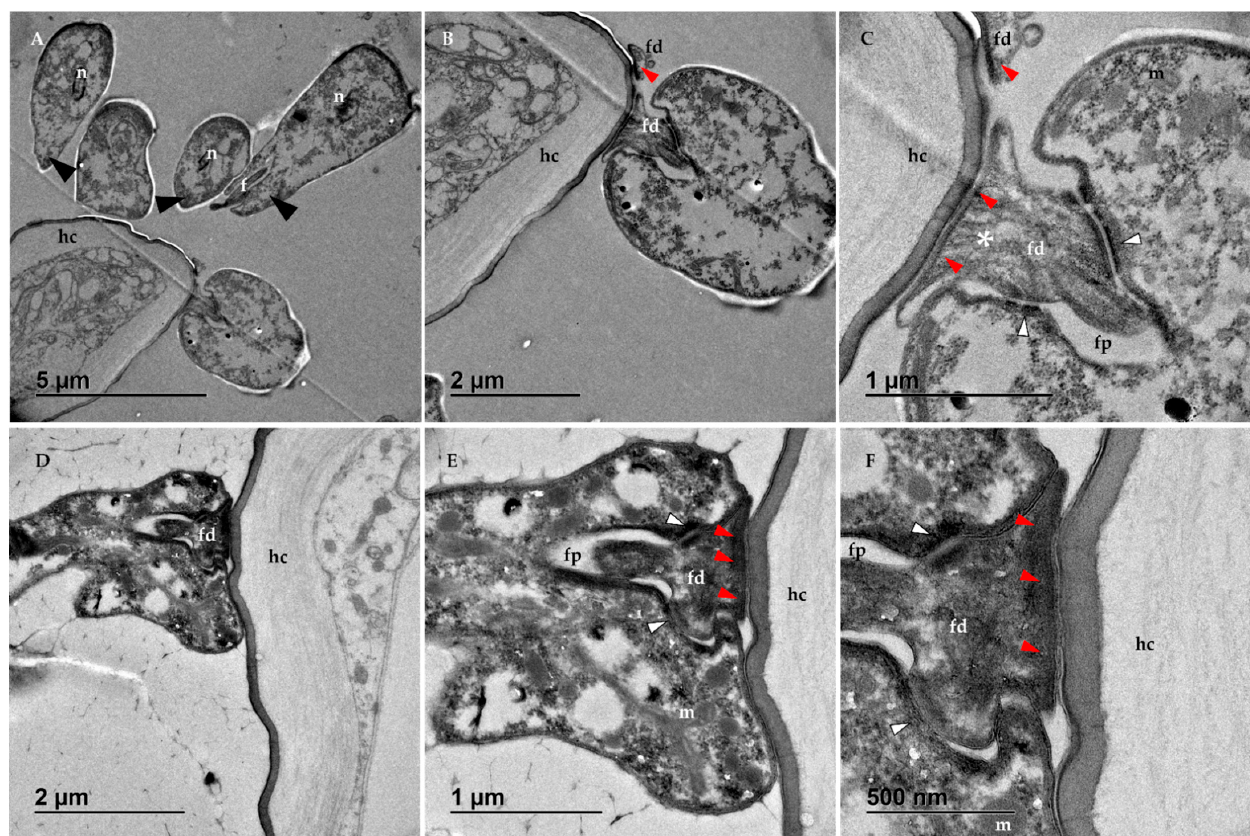
Figure 3. Transmission electron microscopy (TEM) images obtained from the rectum of C. acantho- cephali infected bees: ( A ) longitudinal section that shows different phases of the attachment process, including haptomonads adhered to the host cell (hc) and non-attached trypanosomatids with their flagella (f) oriented to the host surface (black arrowheads). ( B , C ) Details of the haptomonad cells and its flagellopodium (fd), which is surrounded by the flagellar pocket (fp) and is held together with the cell body through the type A desmosomes (white arrowheads). Hemidesmosome-like complexes are observed between the flagellopodium and the host surface (electron-dense material underneath the attachment pad: red arrowheads), while an array of filaments reinforce the entire complex (as- terisk). Some organelles could be observed inside the trypanosomatids, such as the nucleus (n) and the mitochondria (m). ( D ) Haptomonad attached to the cuticular layer of the honey bee epithelial cells (hc), with the axoneme (ax) visible at the base of the flagellopodium (fd). ( E , F ) Details of the flagellopodium (fd), where type A desmosomes (white arrowheads) and the hemidesmosome-like complexes (red arrowheads) could be